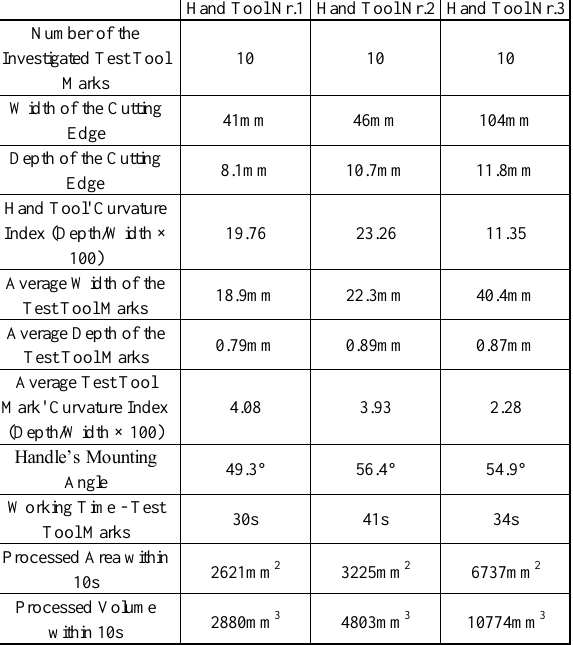
Table 1. The results of the archaeological experiment